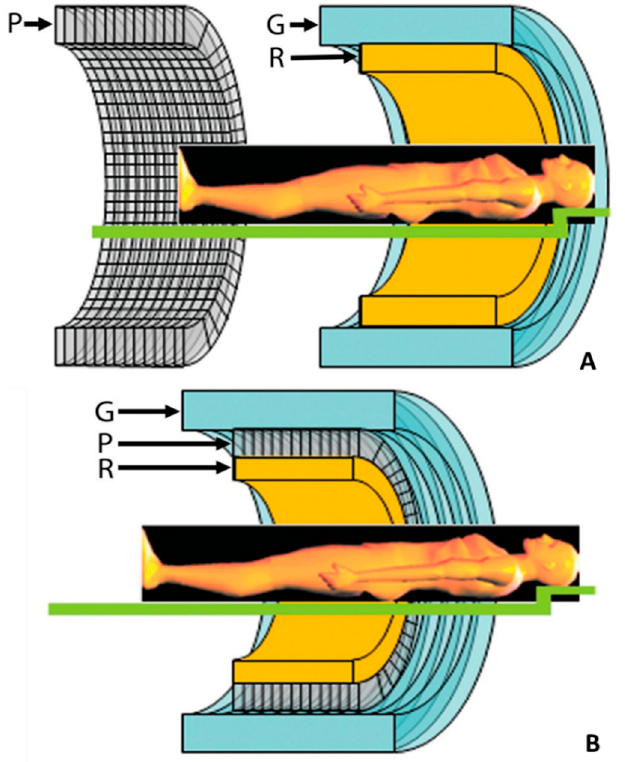
Figure 1. Schematic cross-sectional views of potential designs for combined PET/MR imaging systems: ( A ) sequential design with two imagers mounted from end to end and ( B ) fully-integrated design with the PET imager (P) in between the radiofrequency coil (R) and the gradient set (G) of the MR imager ( bottom ). Adapted from Torigian et al., 2013, by permission of Radiology [23] .